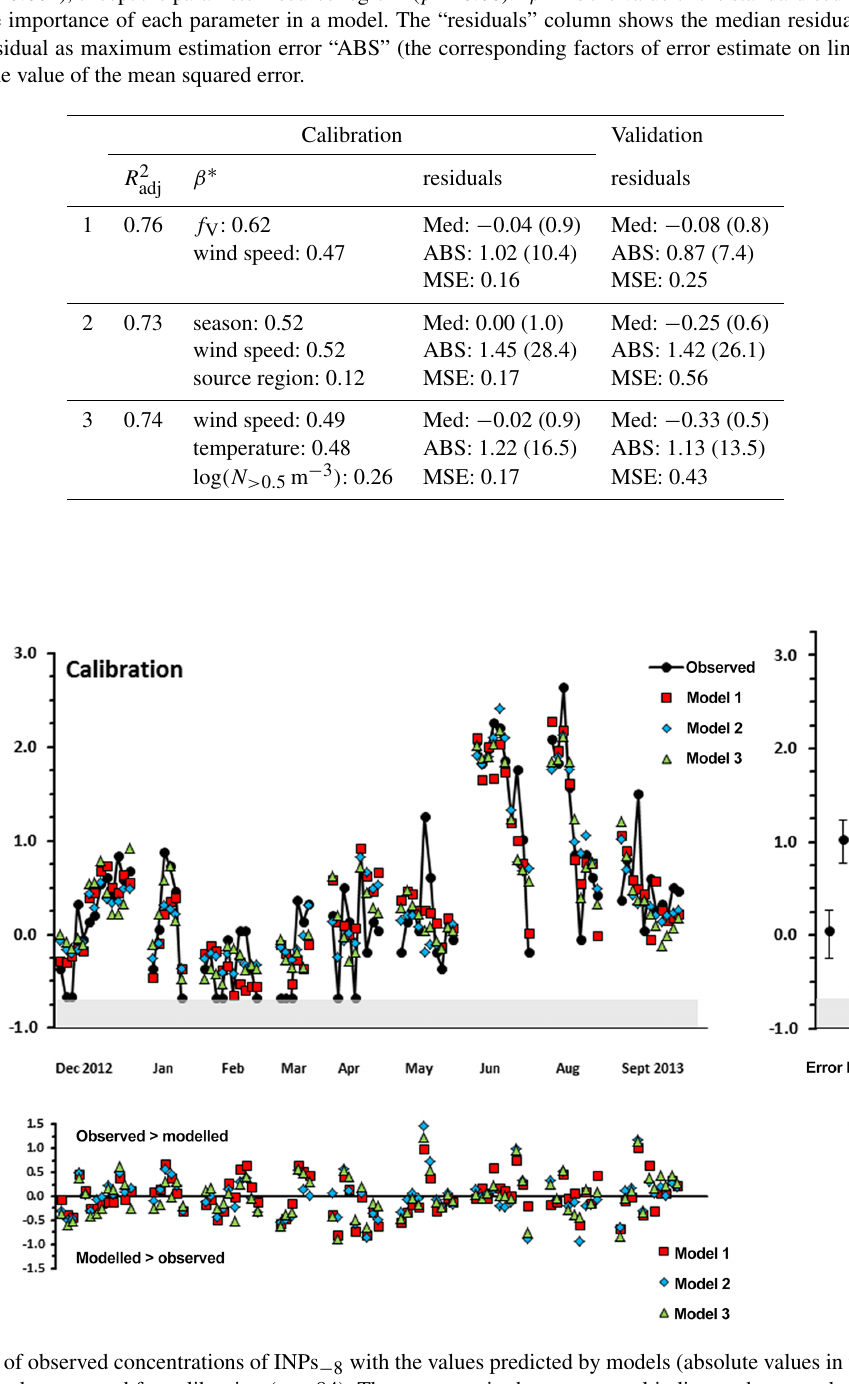
” is the fraction of the observed variance adj